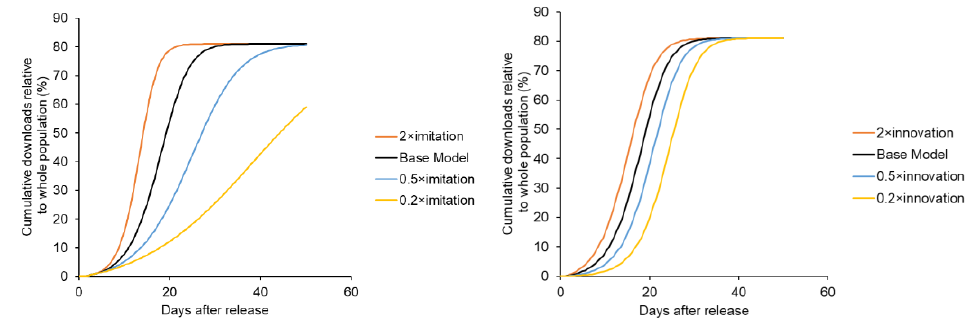
Figure 2. A conceptual system dynamics model of app downloads based on Bass’ new product growth model.